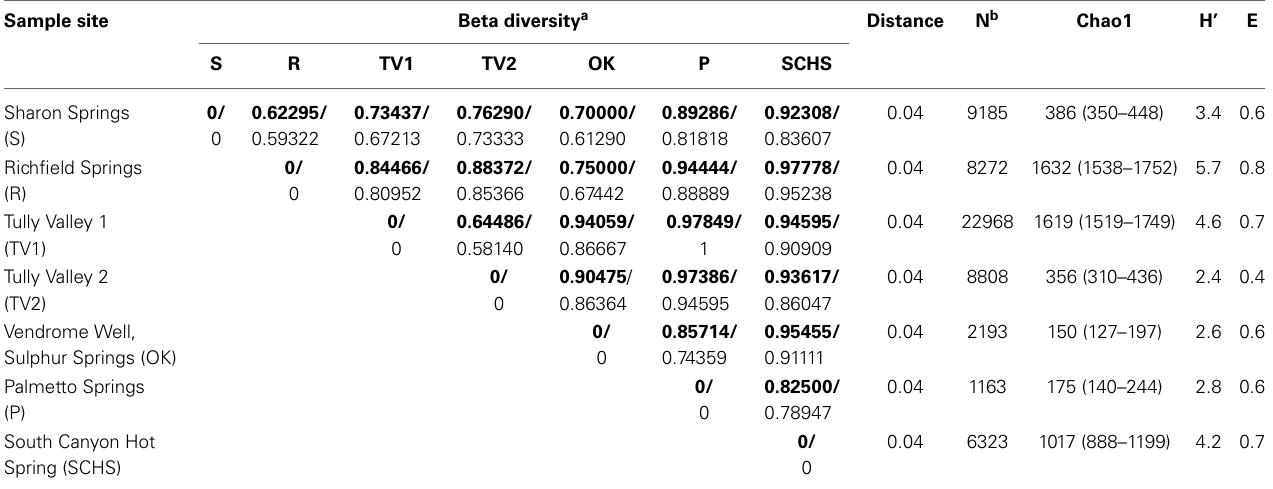
Table 2 | Diversity indices of 16S rRNA